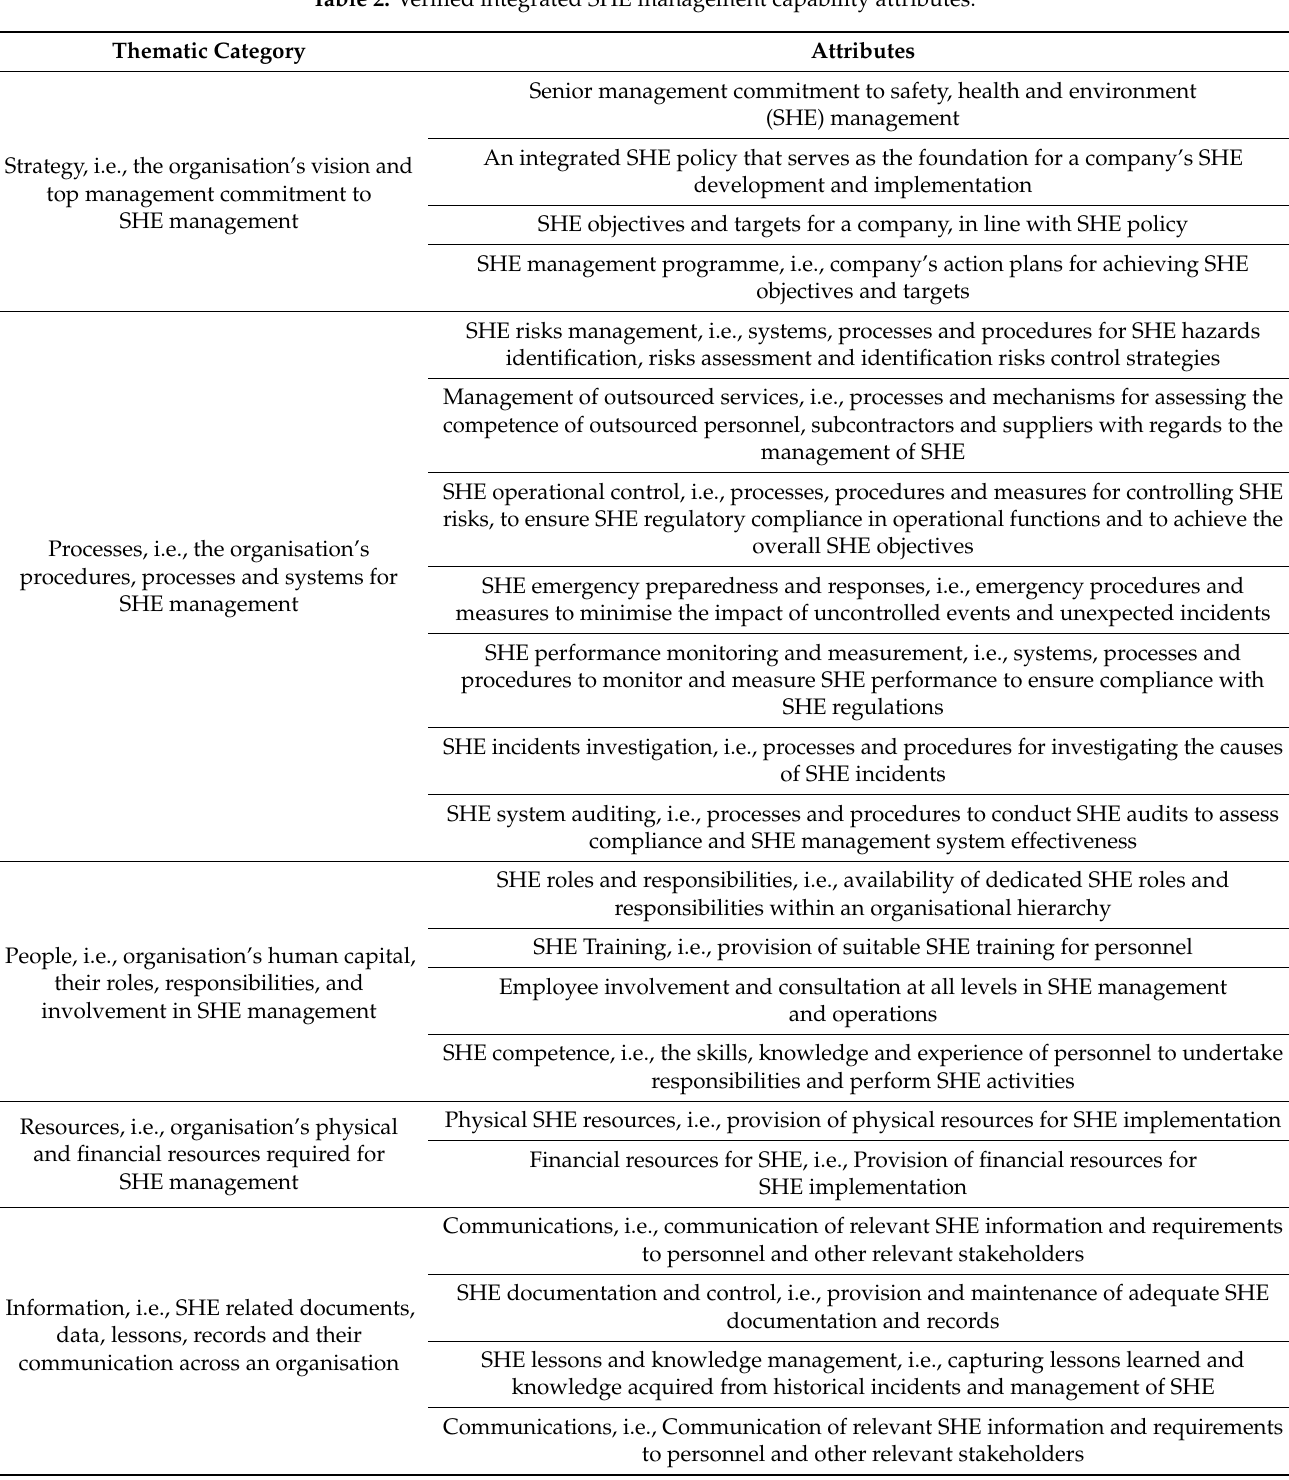
Table 2. Verified integrated SHE management capability